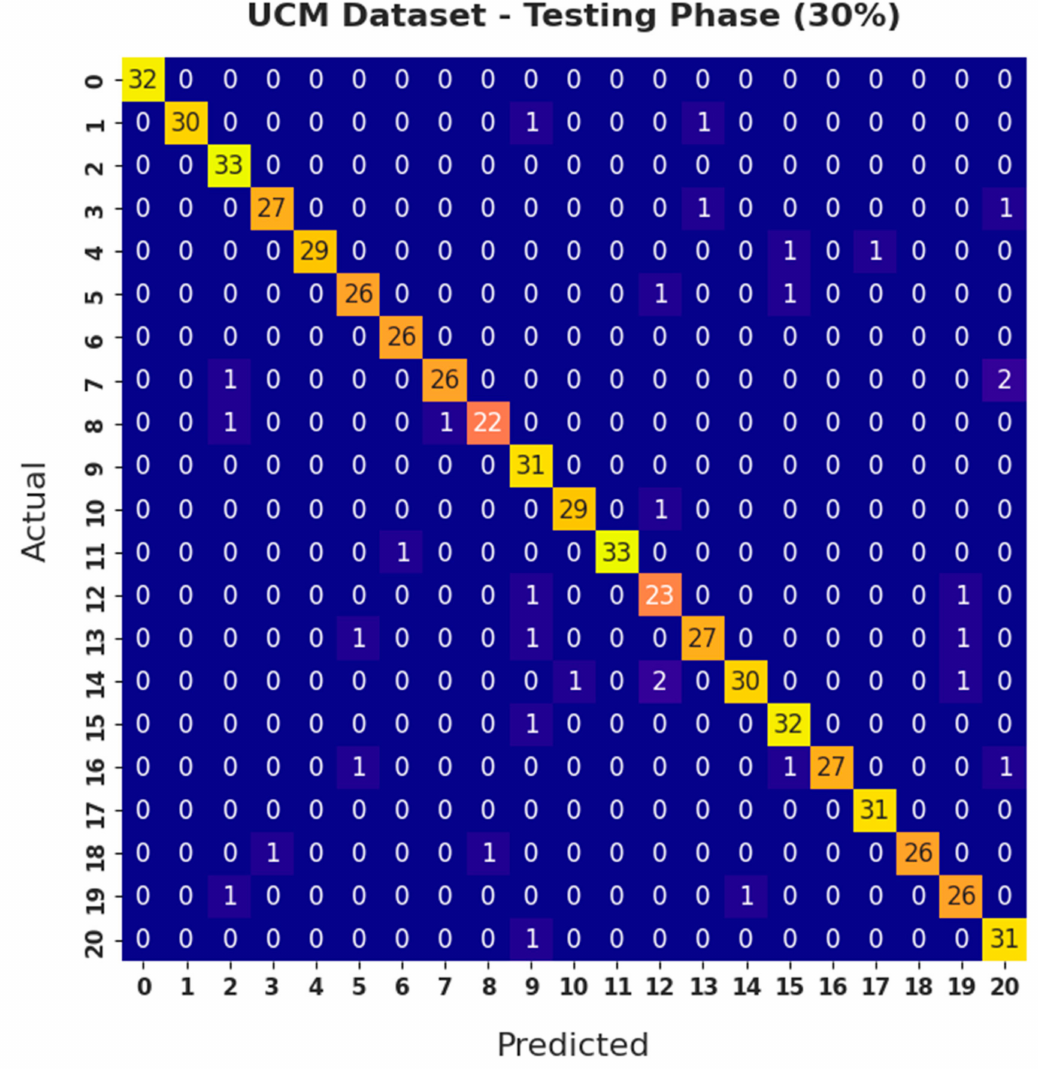
Figure 5. Confusion matrix of SIDTLD-AIC technique on 30% of UCM datasets as testing datasets. Table 2. Result analysis of SIDTLD-AIC technique with various measures on 30% of UCM datasets as testing